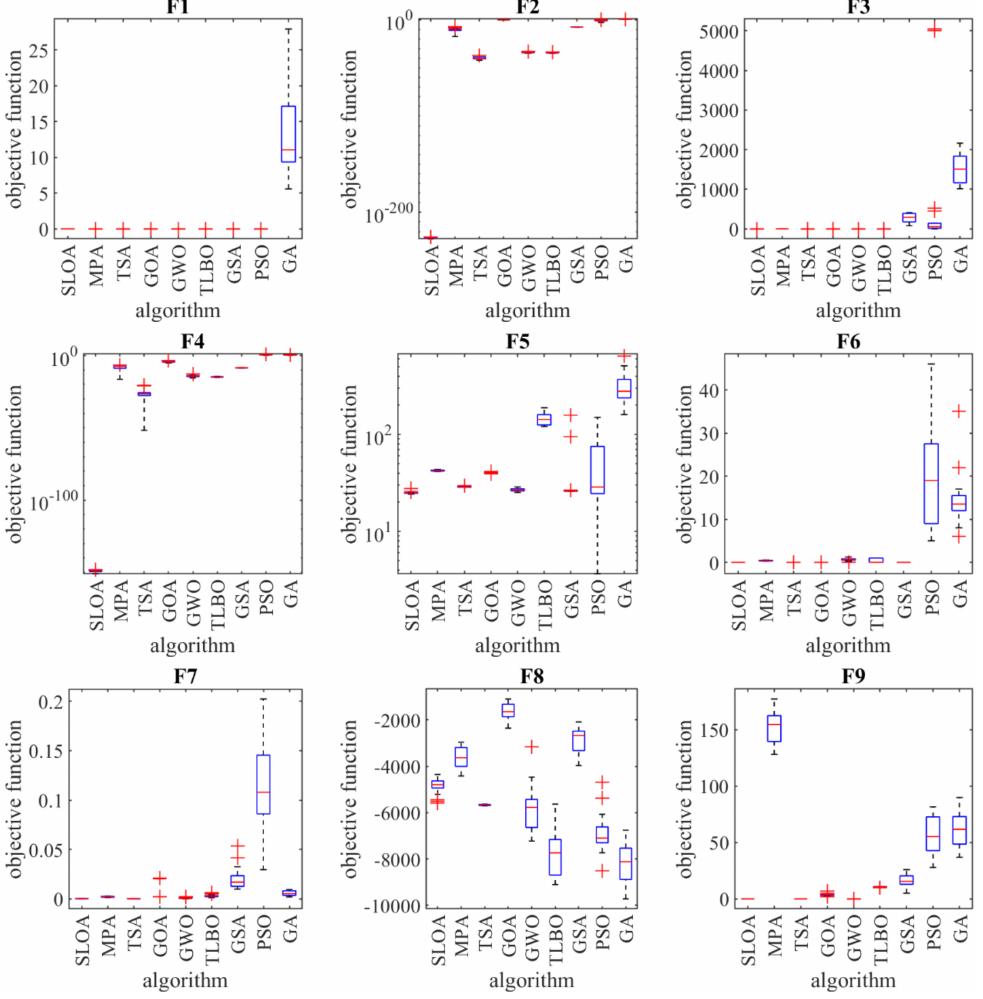
Table 5. Based on the analysis of the results in Table 5, it is concluded that the proposed SLOA has a significant superiority over the other eight algorithms in cases where the p -value is less than 0.05. Accordingly, the proposed SLOA has a significant superiority over all eight compared algorithms in optimizing the F1 to F7 unimodal functions. In optimizing high-dimensional multimodal functions, SLOA has a significant superiority over MPA and GOA with p -value of less than 0.05. Also, in optimizing fixed-dimensional multimodal functions, the proposed SLOA with p -value of less than 0.05 has a significant superiority over all eight algorithms